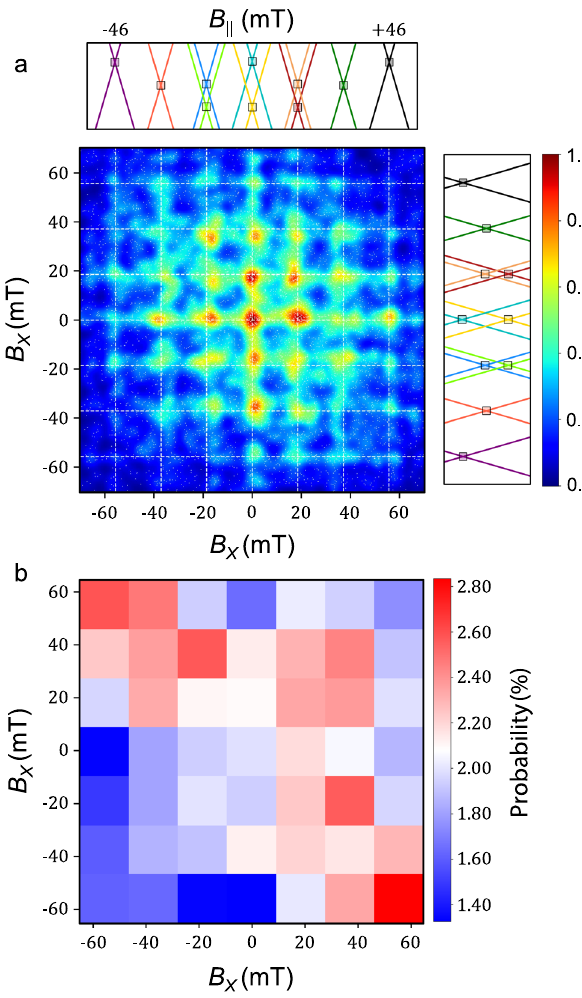
Fig. 4 Transition matrix of the QTM events. a Correlation measurement of the electronic spins reversals. The abscissa corresponds to a conductance jump position during a magnetic fi eld sweep, representing the reversal of the electronic spin orientation, and the ordinate to the conductance jump position during the next sweep. A Gaussian fi lter is applied to highlight the higher densities. The Zeeman diagram is rescaled to ease the identi fi cation of the anti-crossing positions, where QTM is predicted. b Correlation measurement histogram of the electronic spins, taking into account the anti-crossing degeneracies. The events are binned into a 7 × 7 histogram and normalised by the sum of the corresponding anti-crossing degeneracies, thus expressed as a percentage composition. The blocks corresponding to a nuclear spins state change exhibit a higher probability.